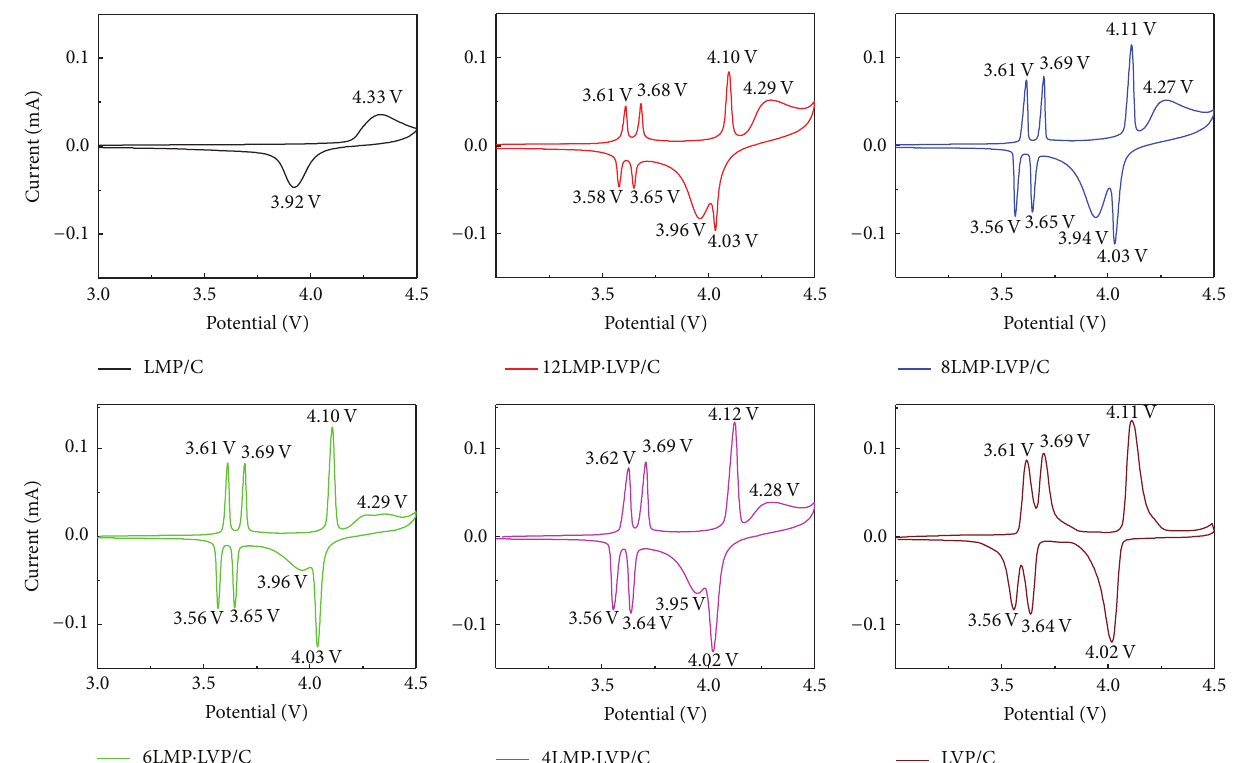
Figure 6: Cyclic voltammetry profiles of the x LMP ⋅ y LVP/C